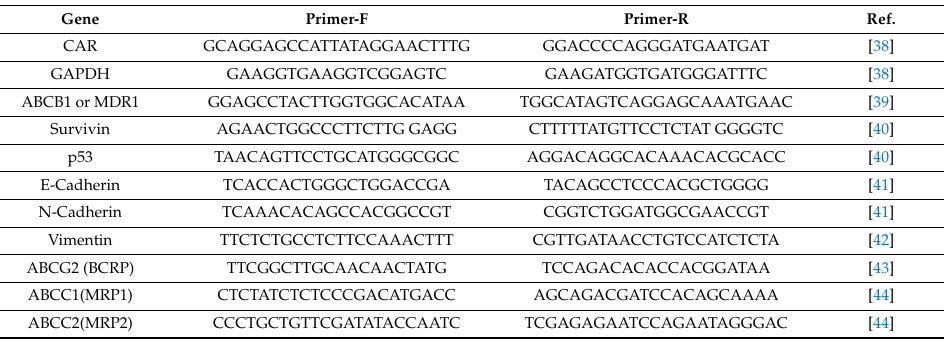
Table 1. Primer sequences for